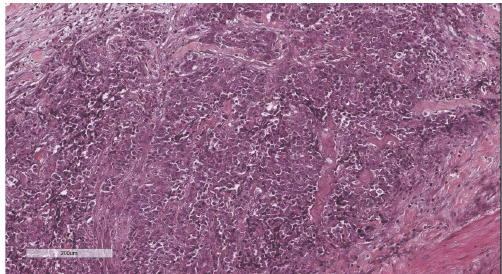
Figure 3: Microscopic examination reveals a small round cell tumor with high mitotic activity arranged in tight nests separated by a delicate capillary network (H&E staining; 20x).